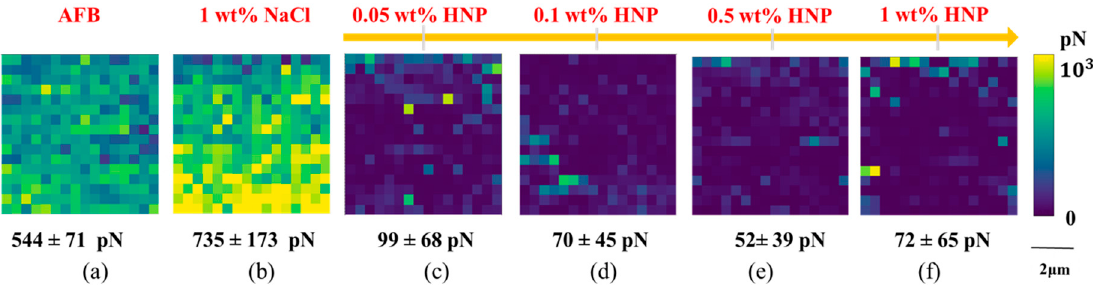
Figure 9. Force volume maps collected over a 5 μ m × 5 μ m scan area characterizing the adhesion of of non-polar C 6 H 5 groups to mica in brine solutions—( a ) AFB and ( b ) 1 wt% NaCl—and nanofluid non-polar C 6 H 5 groups to mica in brine solutions - ( a ) AFB and ( b ) 1 wt% NaCl - and nanofluid solutions—( c ) 0.05 wt%; ( d ) 0.1 wt%; ( e ) 0.5 wt%; ( f ) 1 wt% HNP. AFB is a formation brine